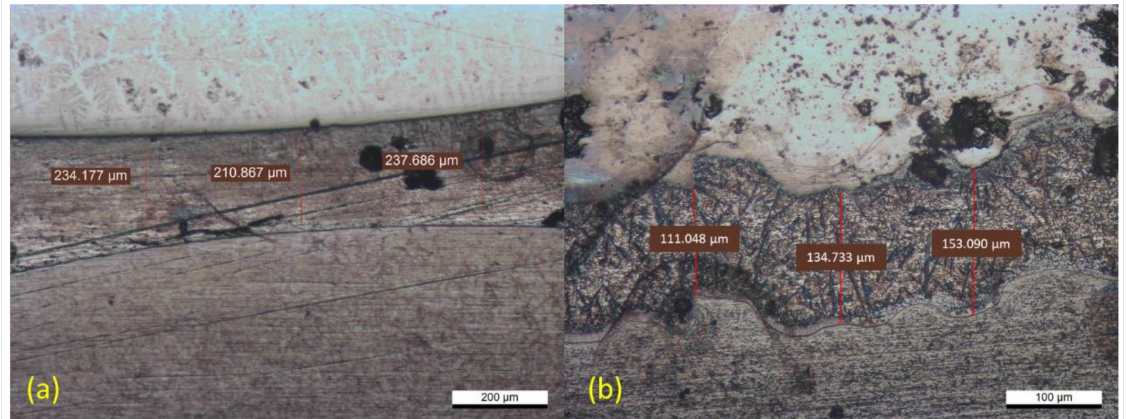
Figure 9. Aluminum interlayer morphology: ( a ) Sample 1—weld current: 11 kA, electrode force: 3 kN; ( b ) Sample 3—weld current: 13 kA, electrode force: 5